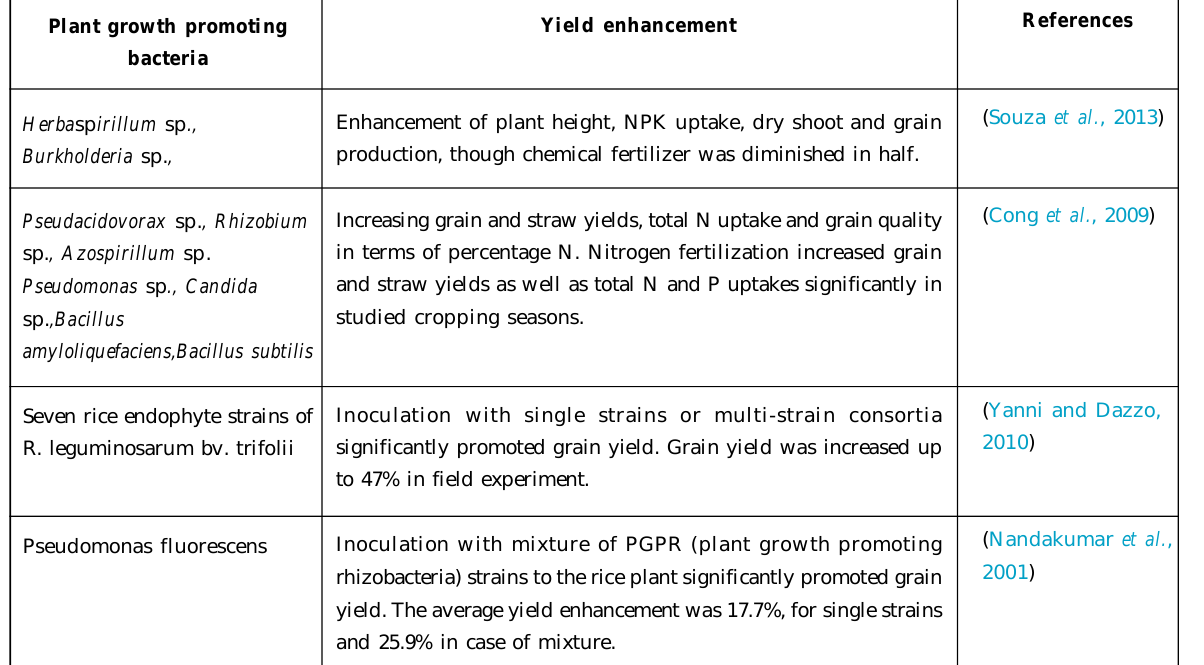
Table 1: Some reported experiments where PGPBs (as single inoculants or combinations) have been showed to augment rice physiological status (yield) under several climate conditions Plant growth